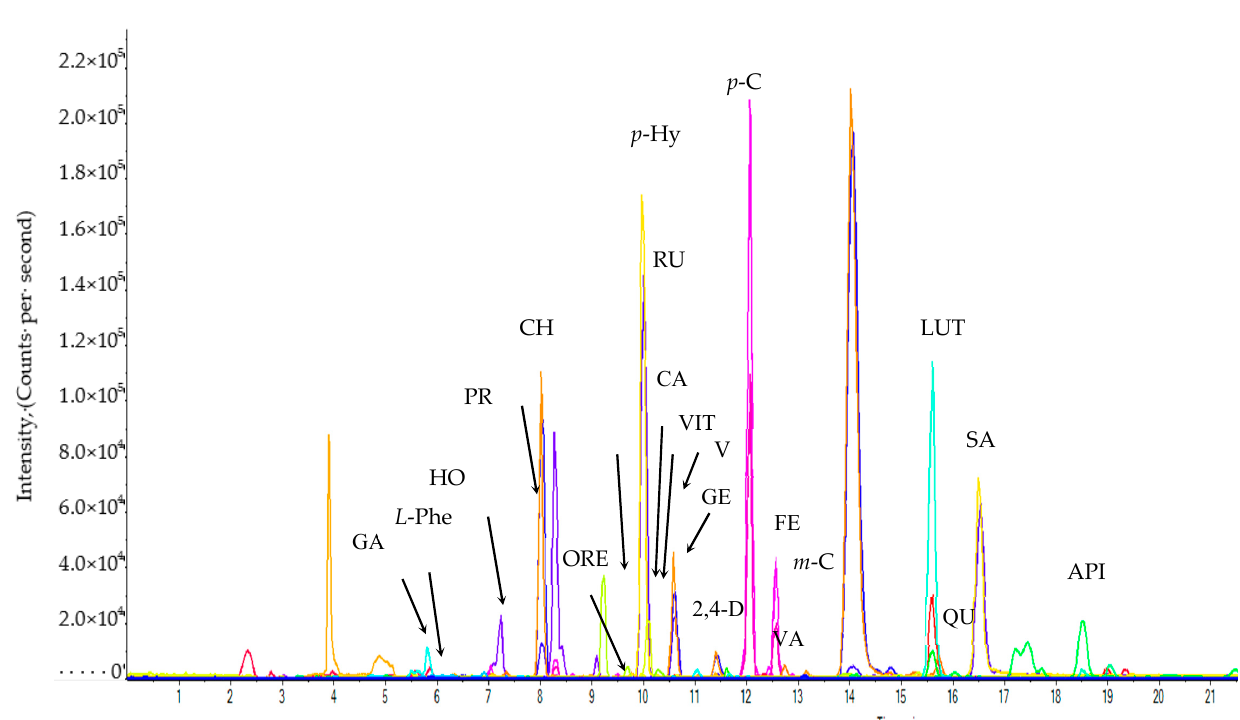
Figure 3. Representative multiple reaction monitoring mode (MRM) ion chromatogram of MS-448 accession. GA: